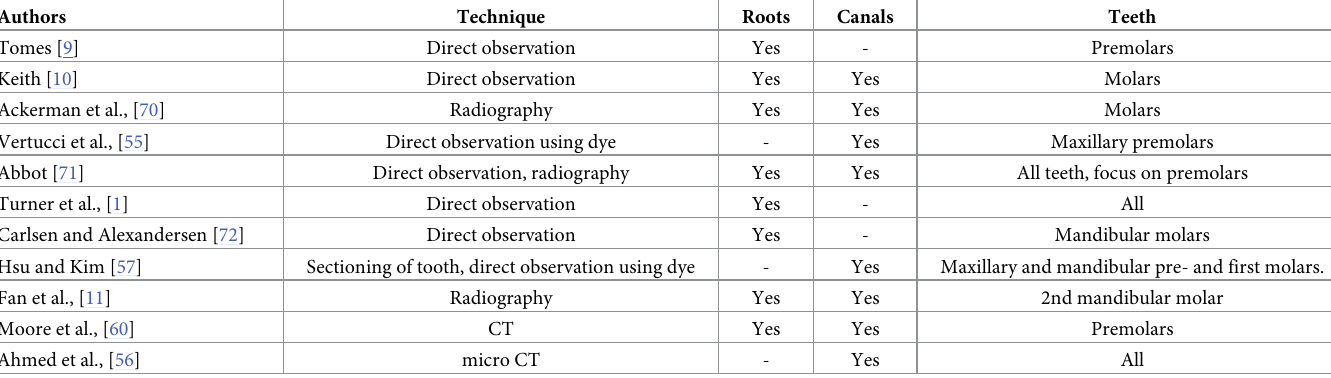
Table 1. Previous typological studies of tooth roots and canals in modern